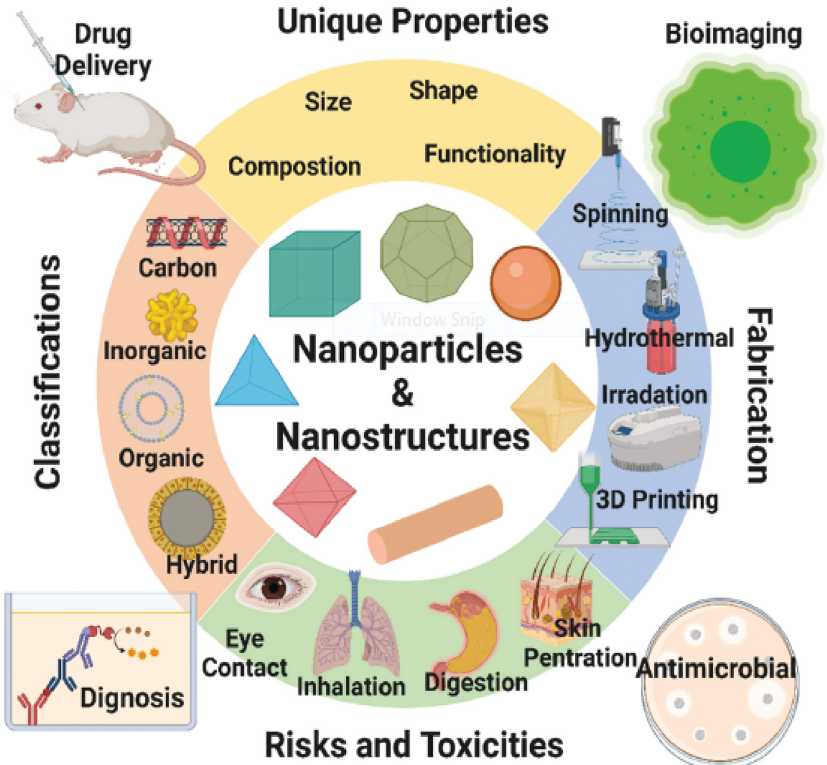
Figure 1: Applications of nanoparticles and nanostructure